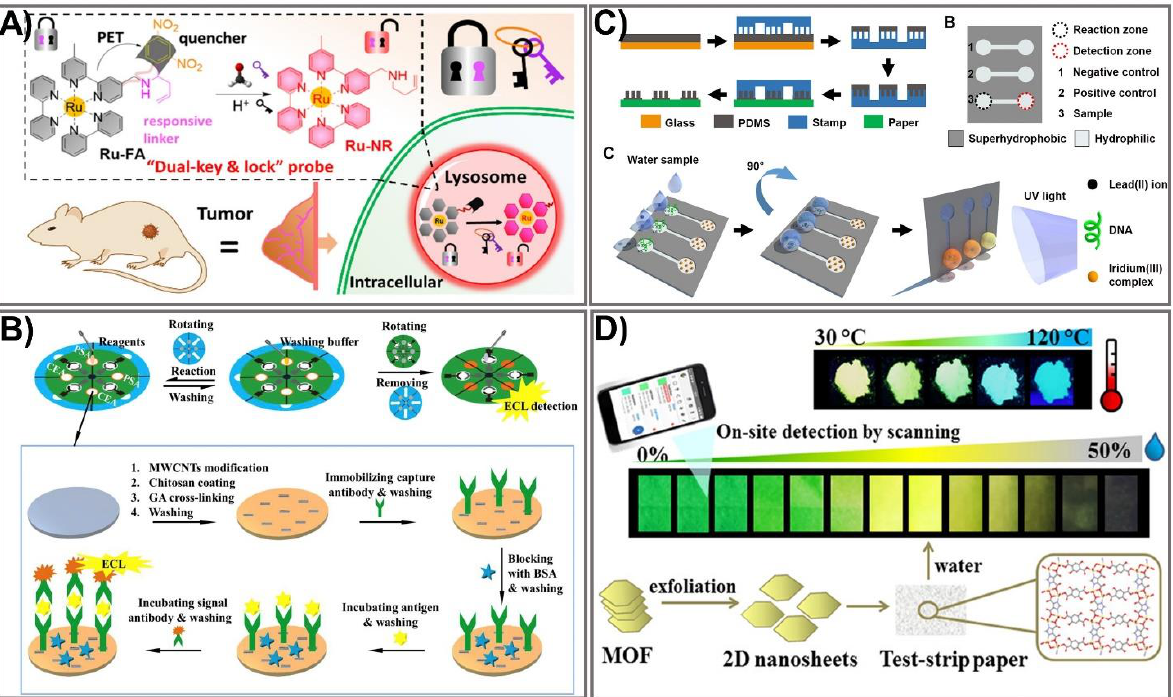
Figure 3. Luminescence-based PADs with enhanced detection sensitivity. ( A ) The schematic of the PAD assay for lysosomal formaldehyde detection using dual-key-and-lock ruthenium (II) complex probe as a signal amplification strategy. Adapted with permission from Ref. [77] . ( B ) Schematic illustration for the implementation of 3 paper discs in a rotational paper-based valve for a multi-step electrochemiluminescence immunoassay for the detection of carcinoembryonic antigen and prostate-specific antigen cancer markers. Adapted with permission from Ref. [79] . ( C ) Schematic representation of the suspended-droplet mode-based luminescence PAD design process for the detection of lead (II) ions in water samples. Adapted with permission from Ref. [81] . ( D ) The schematic principle of the excited-state proton transfer concept-based luminescence PAD for water and temperature sensing. Adapted with permission from Ref. [82] .